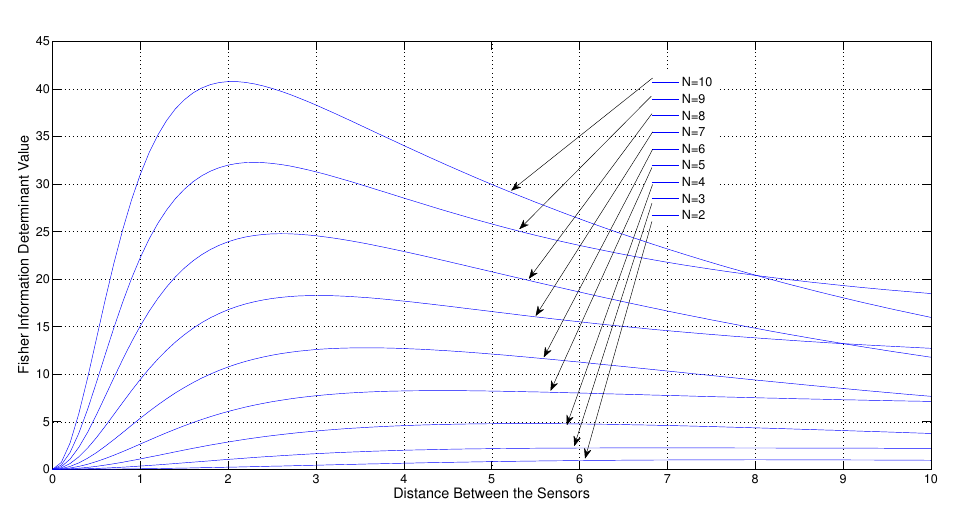
Figure 11. Variation of Fisher information determinant value with the distance between two adjacent sensors of ULA for different number of range sensors (All